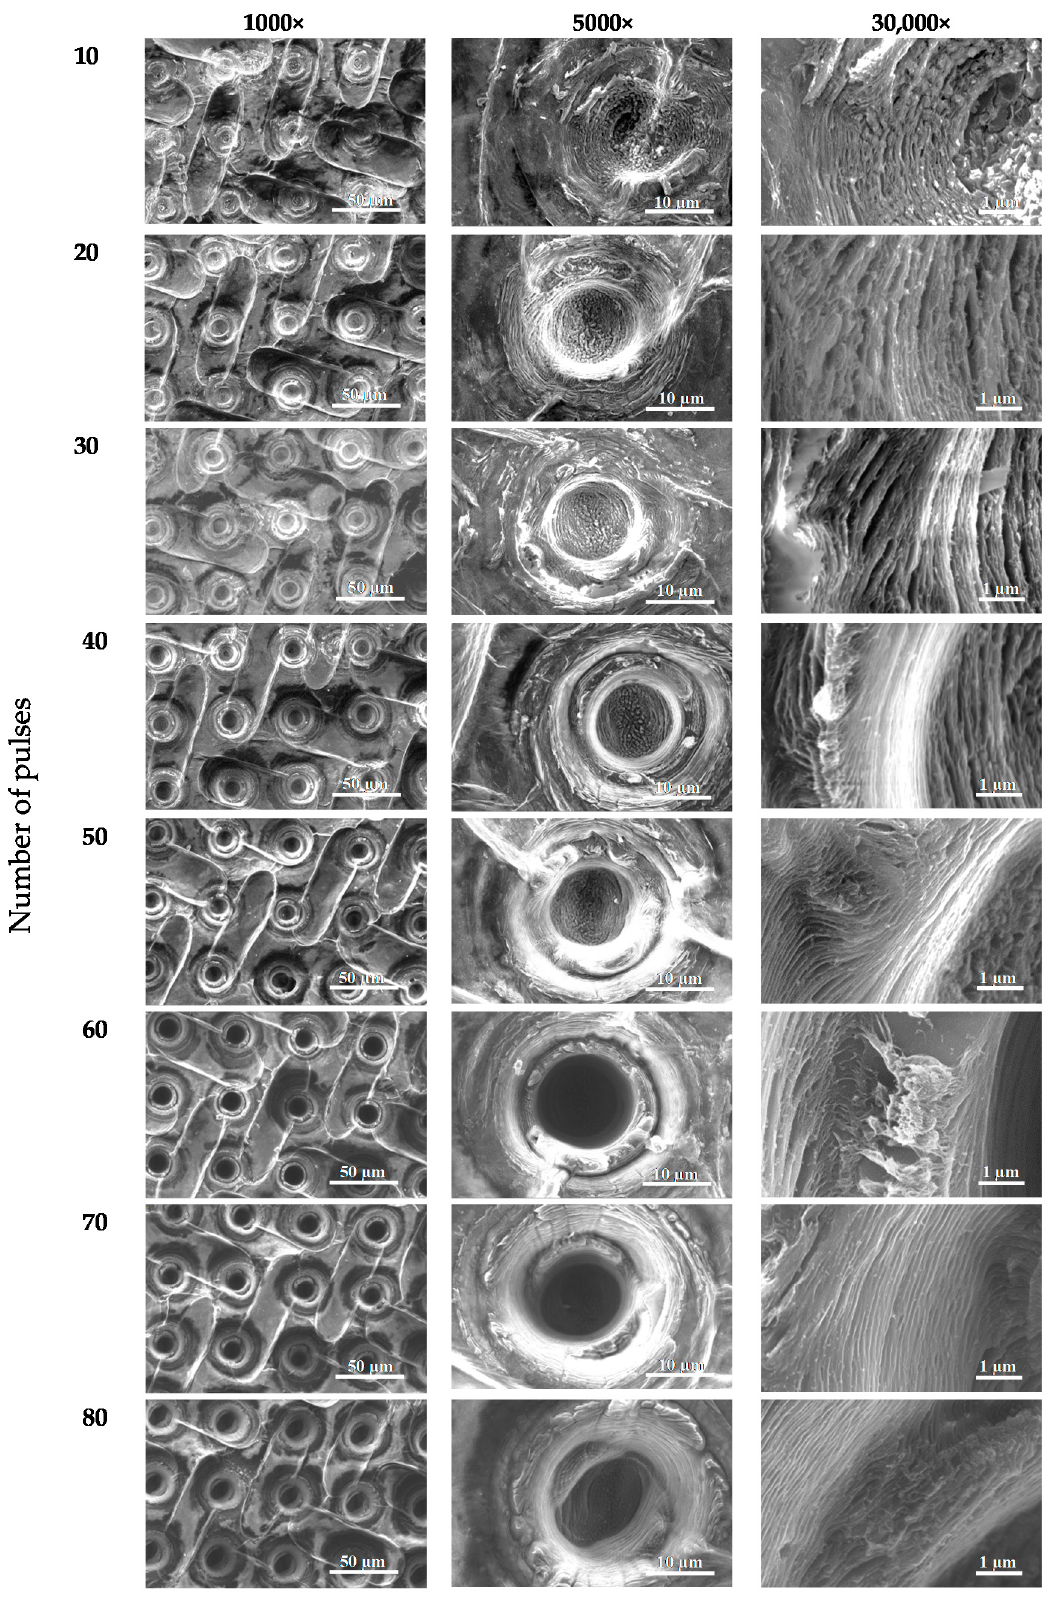
Figure 4. SEM images of the boundary areas of the craters created in graphene paper by a laser ablation method (pulse energy—10 µJ).